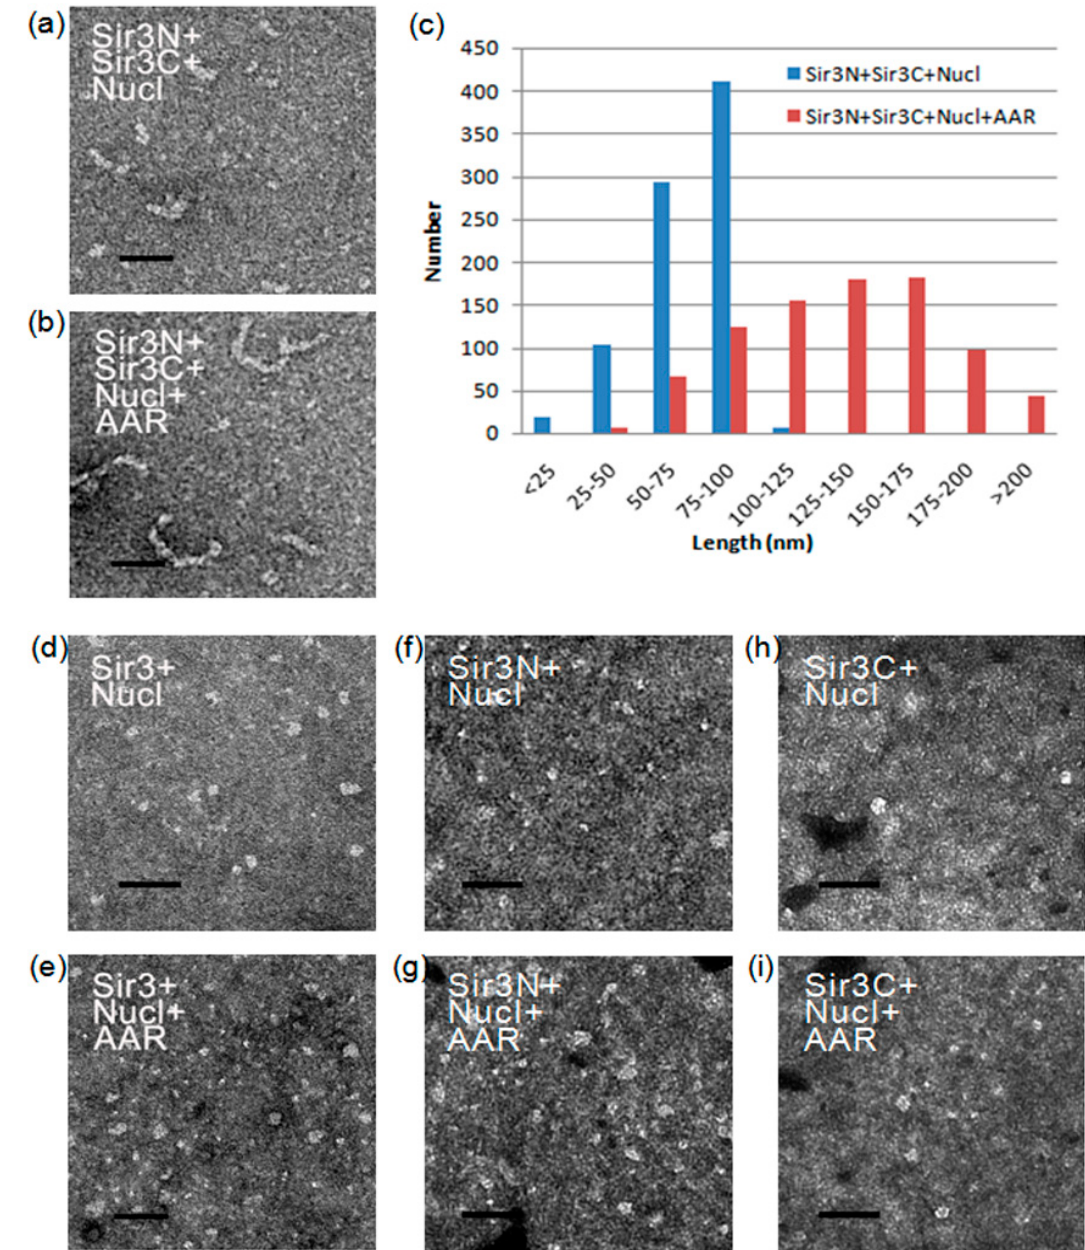
Figure 5. Morphology of Sir3-AAR-nucleosome particles. ( a–b ) Electron micrographs show the results of the assembly reactions containing yeast nucleosomes, Sir3N, and Sir3C in the absence ( a ) or presence ( b ) of AAR, respectively. ( c ) The length distributions of Sir3NC-nucleosome and Sir3NC-AAR-nucleosome are displayed. The quantification of each EM examination was performed in at least triplicate. The length of the particles was measured in randomly pick-up from at least three distinct fields of view on the electron microscopy (EM) grid. ( d – i ) Electron micrographs show the results of the assembly reactions containing yeast nucleosomes and Sir3 ( d – e ) (or Sir3N ( f – g ) or Sir3C ( h – i )) in the absence ( d,f,h ) or presence ( e,g,i ) of AAR, respectively. The scale bar represents 100 nm.